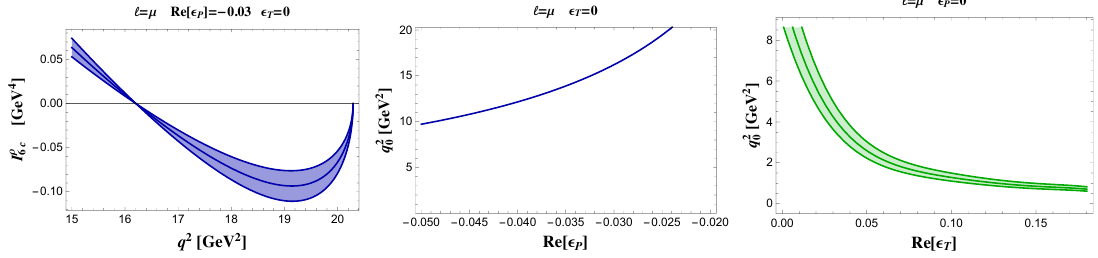
( q 2 ) ( left ), and position of the zero q 2 6 c